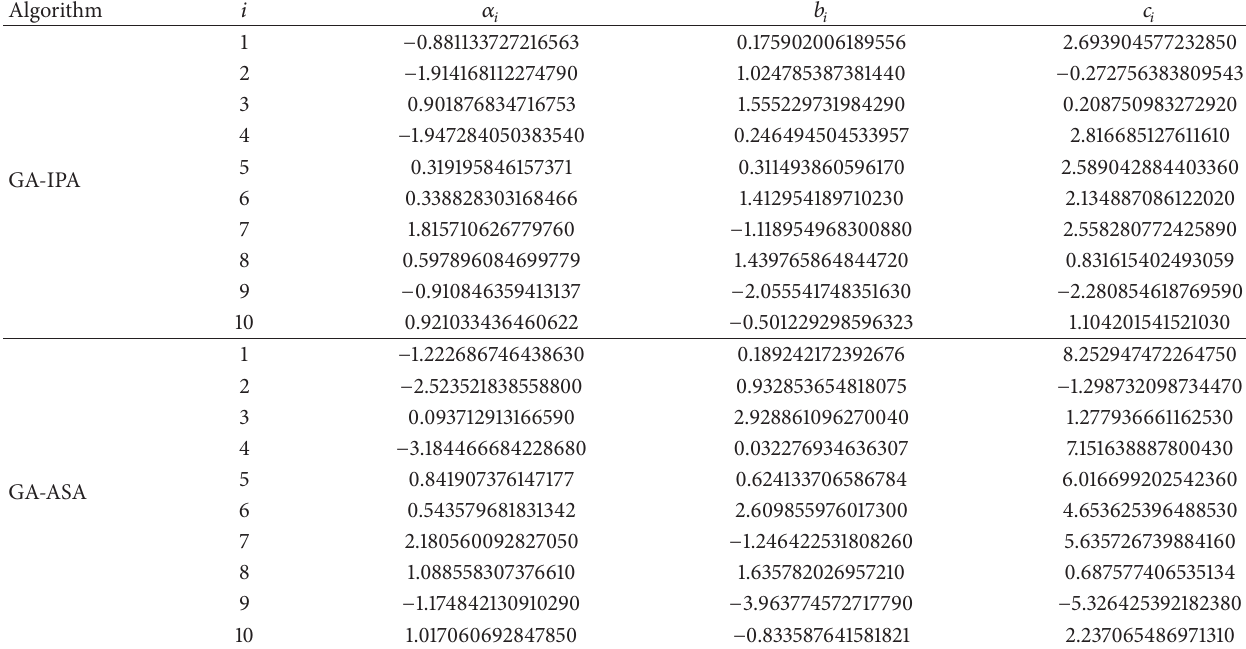
Table 2: Optimal values of adjustable parameters acquired by hybrid schemes GA-IPA and GA-ASA for Example 1.